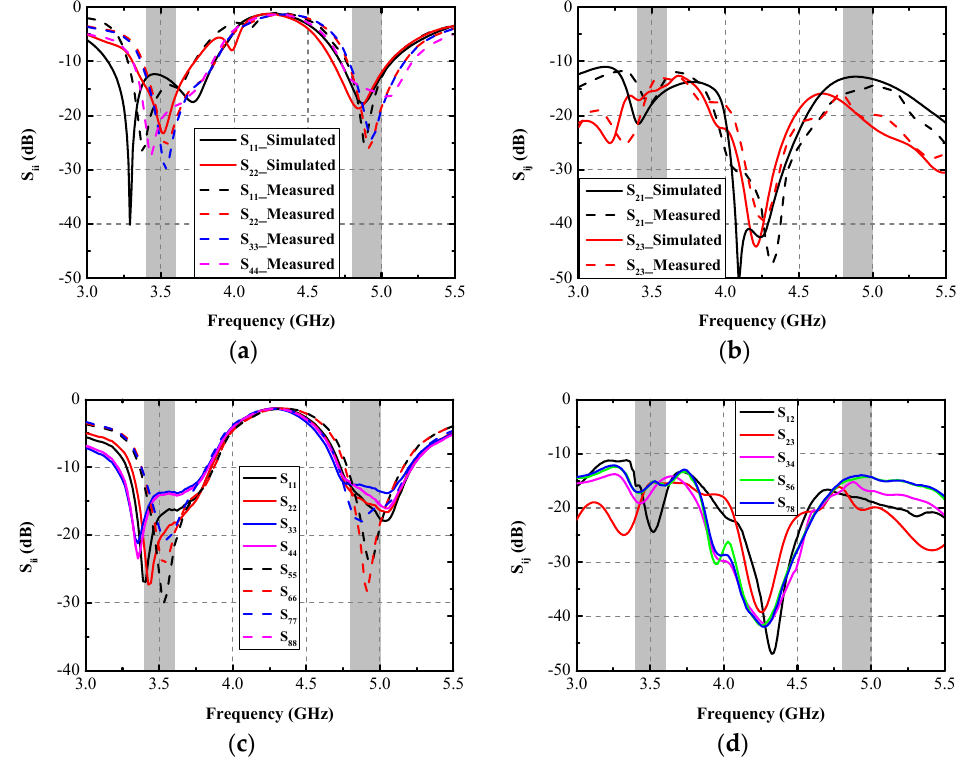
Figure 10. Simulated and measured S-parameters ( a ) S ii , ( b ) S ij , ( c ) measured S ii, and ( d ) measured S ij .